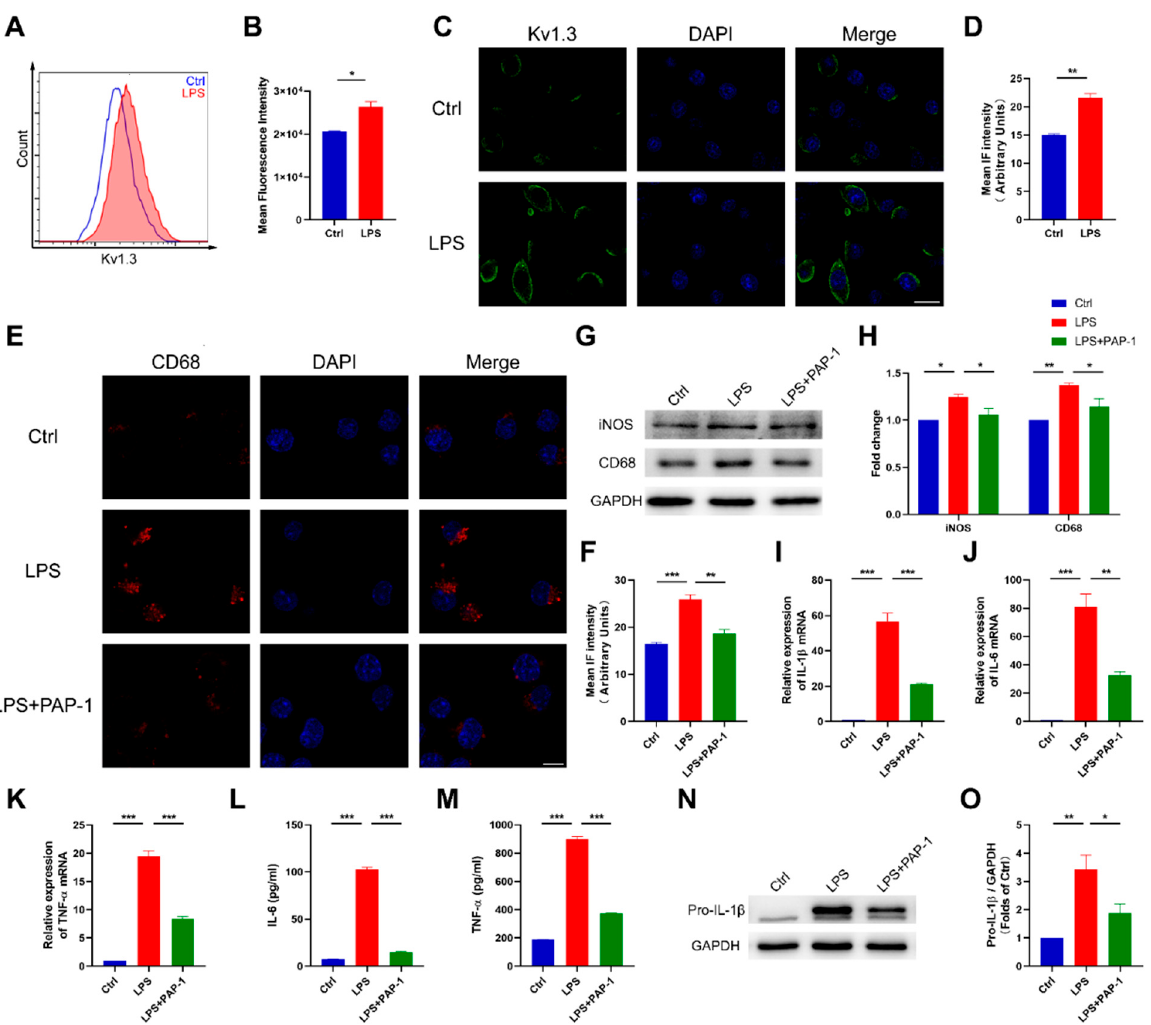
Figure 4. PAP-1 reduced microglial activation and proinflammatory cytokine production in vitro. ( A , B ) Flow cytometric analysis of the surface expression of Kv1.3 in BV2 microglia (n = 3); statistics by unpaired t -test with Welch’s correction. ( C , D ) Immunofluorescence of LPS-induced Kv1.3 protein expression in BV2 microglia (n = 3); statistics by unpaired t -test. Scale bar: 20 µ m. ( E , F ) Representative confocal images showing CD68 expression after treatment in BV2 microglia and statistical analysis (n = 3); statistics by one-way ANOVA with Tukey’s multiple comparisons test, F (2, 6) = 37.55, p = 0.0004. Scale bar: 10 µ m. ( G , H ) Cell lysates were immunoblotted with iNOS and CD68 antibodies, and the results were summarized (n = 3); statistics by one-way ANOVA with Tukey’s multiple comparisons test; iNOS, F (2, 6) = 8.702, p = 0.0168; CD68, F (2, 6) = 13.01, p = 0.0066. ( I – K ) Gene expression of IL-1 β , IL-6, and TNF- α in BV2 microglia after treatment (n = 3); statistics by one-way ANOVA with Tukey’s multiple comparisons test; IL-1 β , F (2, 6) = 109.2, p < 0.0001; IL-6, F (2, 6) = 53.60, p = 0.0001; TNF- α , F (2, 6) = 258.6, p < 0.0001. ( L , M ) IL-6 and TNF- α in the supernatants of BV2 microglia were measured using ELISA (n = 3); statistics by one-way ANOVA with Tukey’s multiple comparisons test; IL-6, F (2, 6) = 50.41, p = 0.0002; TNF- α , F (2, 6) = 45.93, p = 0.0002. ( N , O ) Cell lysates were immunoblotted with IL-1 β antibody, and the results were summarized (n = 3); statistics by one-way ANOVA with Tukey’s multiple comparisons test, F (2, 6) = 34.35, p = 0.0005. Data are depicted as the mean ± SEM. * p < 0.05, ** p < 0.01, *** p <